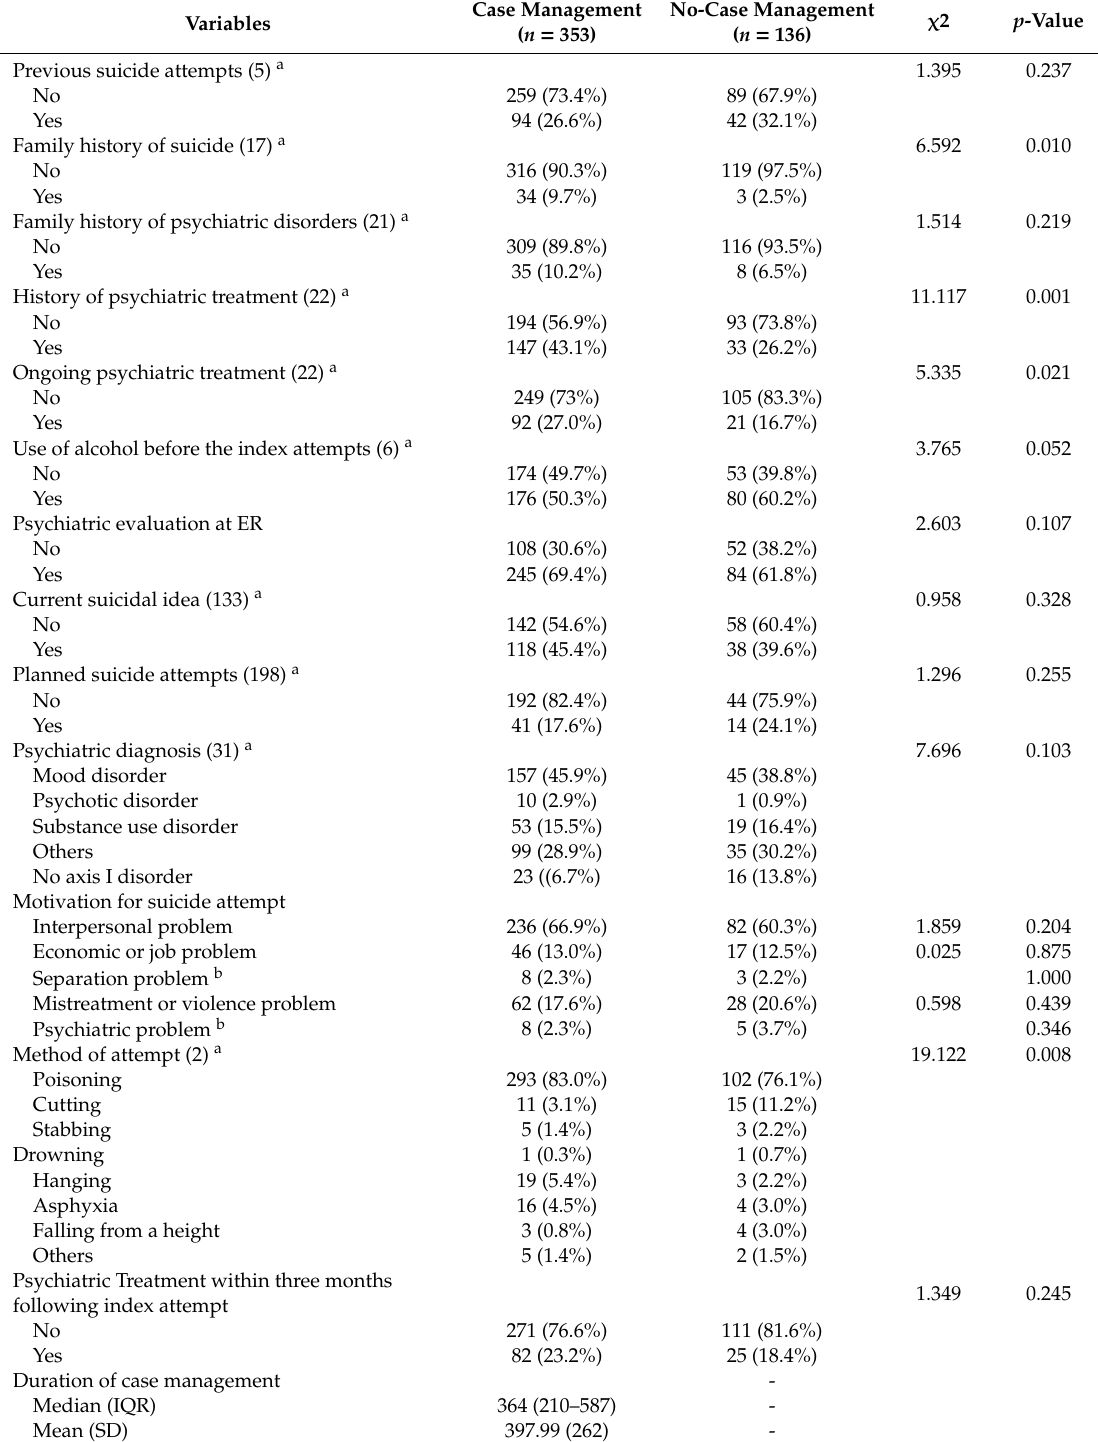
Table 2. Clinical and suicide-related characteristics of the